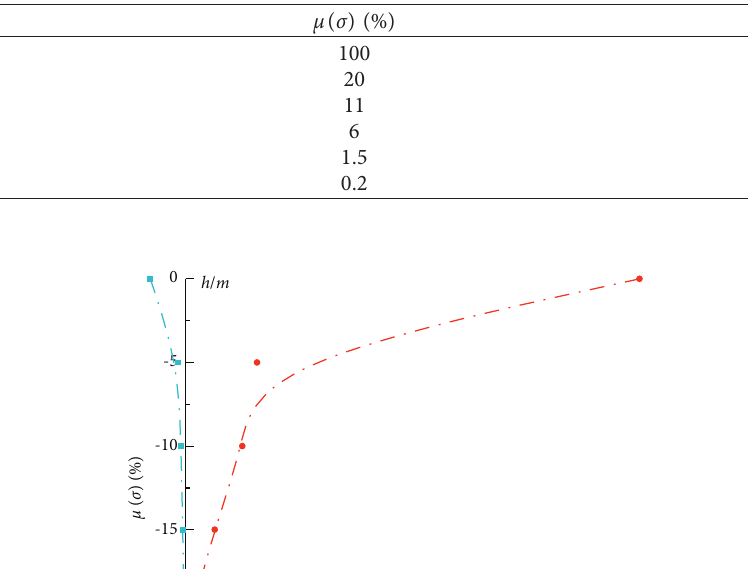
Table 5: Shear stress at different depths and t � 4/8 (kPa).